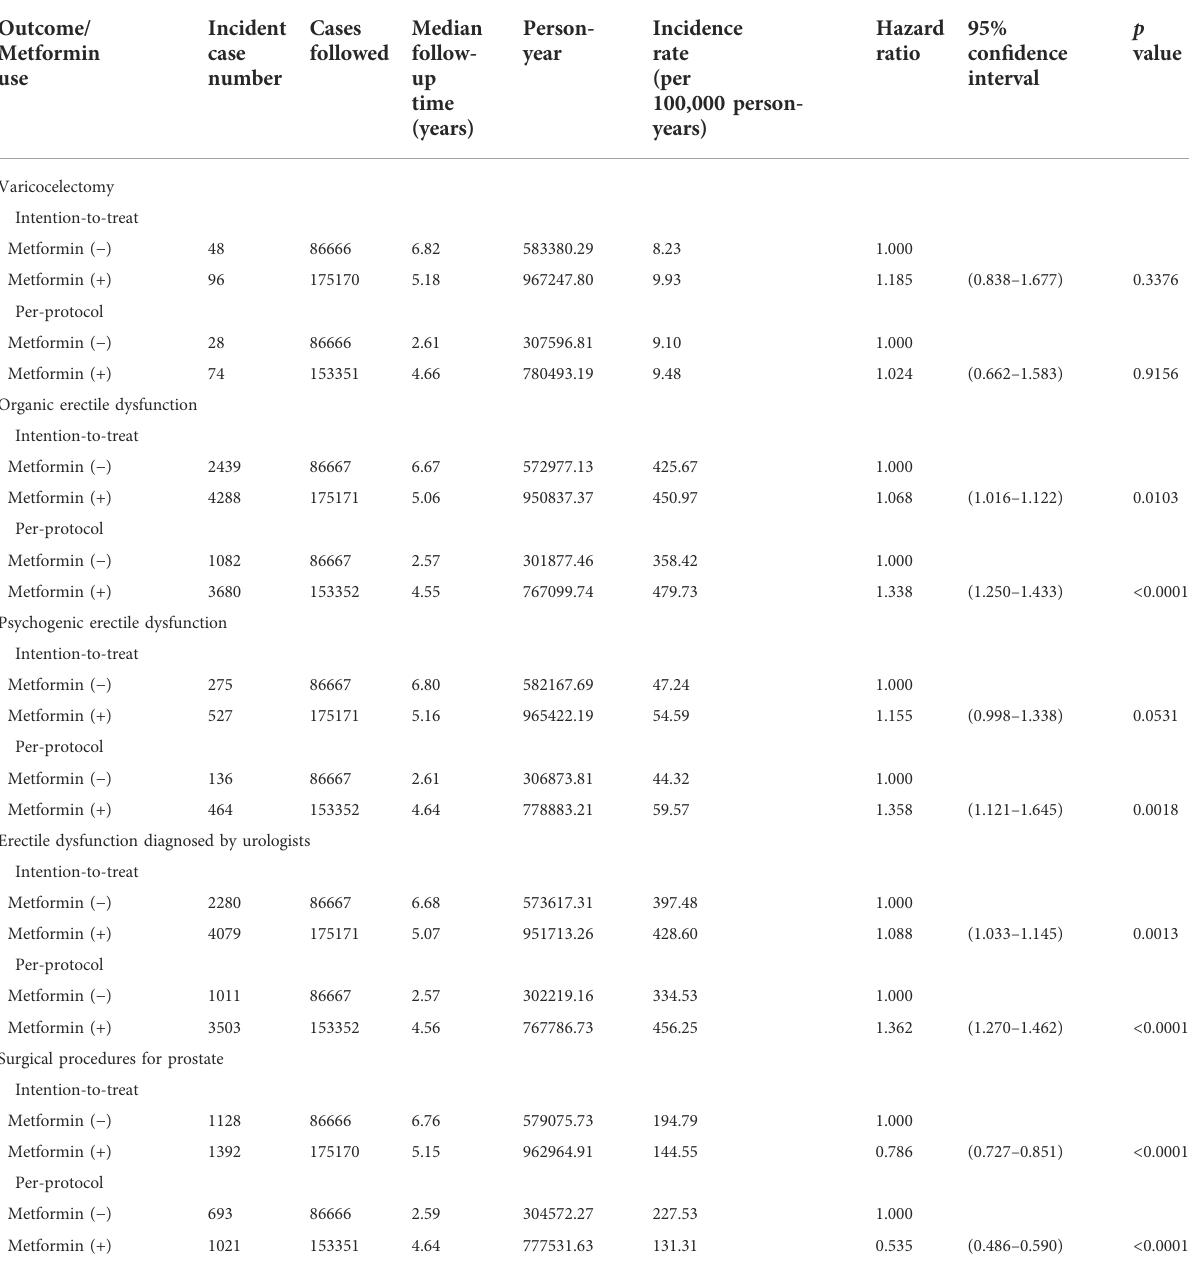
TABLE 3 Sensitivity